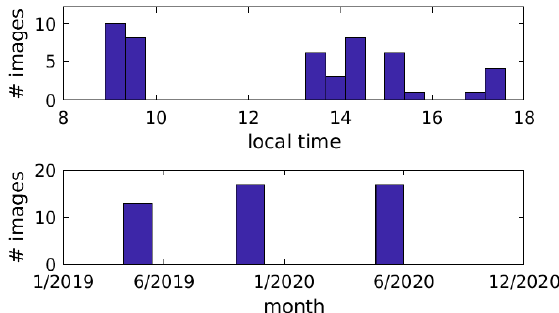
Figure 5. Distribution of selected images across time of day (top) and across months within the years 2019 and 2020 (bottom).